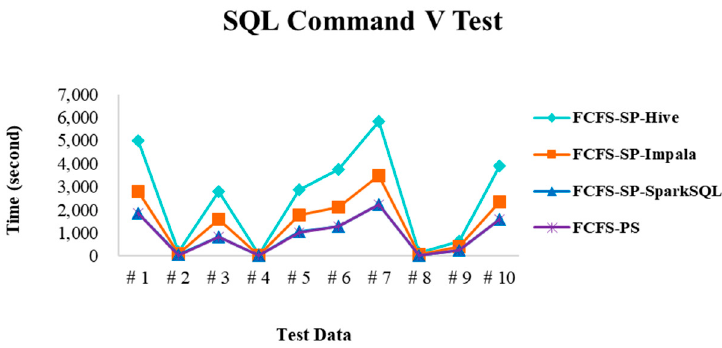
Table 9. Performance comparison among the methods for Case 1 (unit: s).